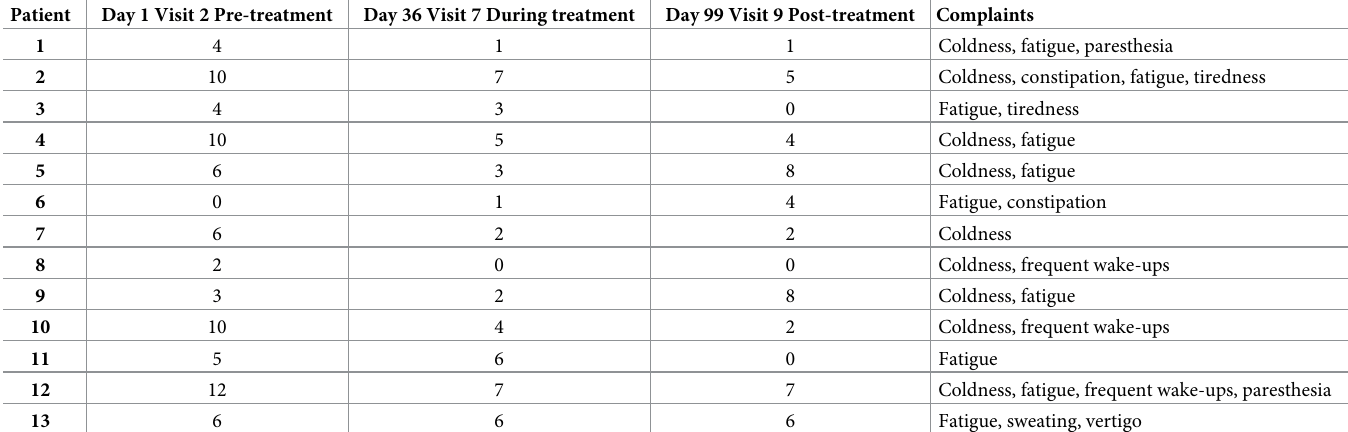
Table 8. Autonomic and sensory scores for individual patients.